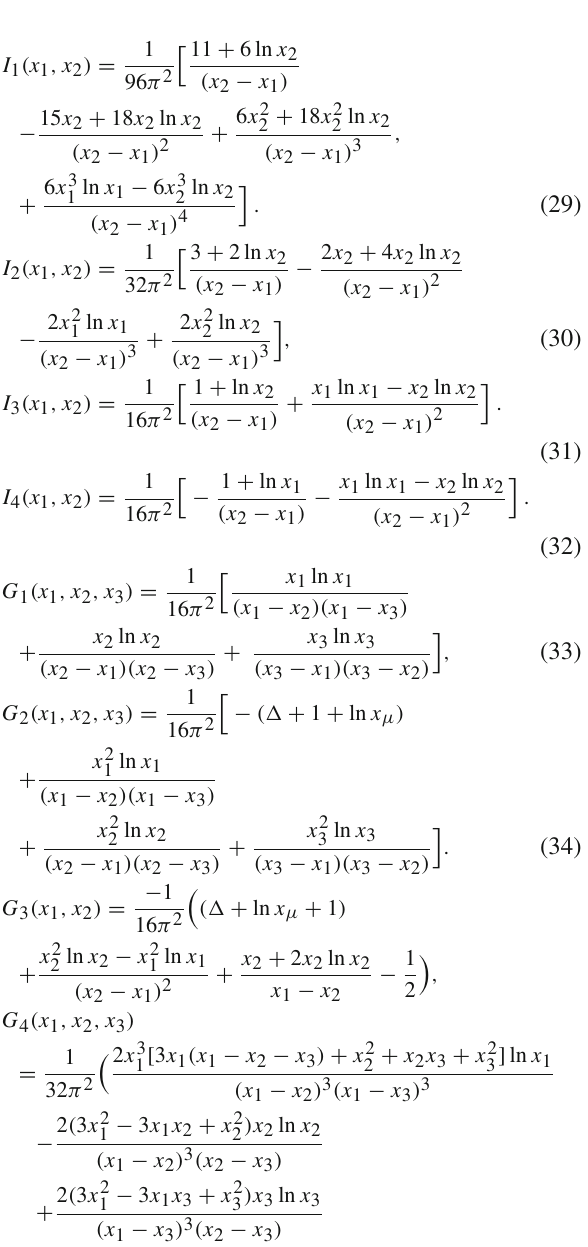
, μ → e conversion rate in nuclei 6